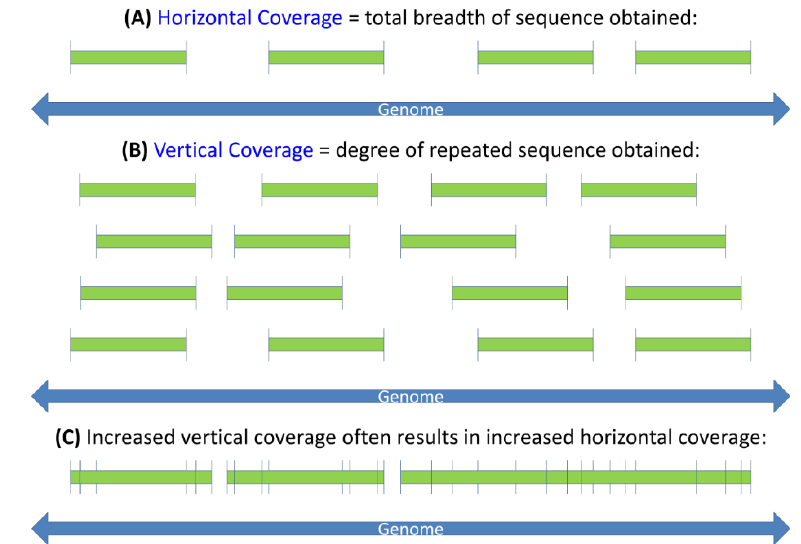
Figure 3. Illustration of horizontal coverage vs. vertical coverage from sequencing reads, and the impact of increased vertical coverage on horizontal coverage. ( A ) A hypothetical genome is shown as a double arrow (blue) with sequencing breadth indicated in terms of horizontal coverage of sequencing reads (green bars). ( B ) Sequencing depth by contrast is indicated in terms of vertical coverage (stacking) of overlapping sequencing reads (also of green bars). ( C ) Taking the sequencing reads providing increased vertical coverage (from B) and collapsing them into a single layer (bottom) illustrates the potential for greater horizontal coverage resulting from increased vertical coverage compared to decreased vertical coverage. Note that increased vertical coverage can also increase sequencing accuracy in terms of defining consensus sequence, though this potential increase in sequencing accuracy is not indicated in the figure.